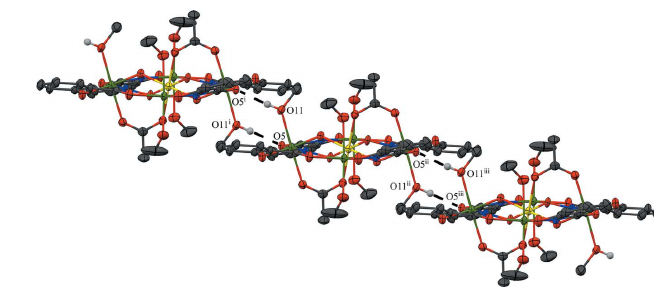
Figure 3 Intermolecular hydrogen bonding (dashed lines) between the carboxylate oxygen atom (O5) of a shi 3 (cid:3) ligand and a coordinated methanol molecule (O11) of a neighboring metallacrown that then generates a one- dimensional chain. For clarity only the hydrogen atoms involved in the interactions have been included. [Symmetry codes: (i) (cid:3) x + 1, (cid:3) y + 2, (cid:3) z + 1; (ii) (cid:3) x + 1, (cid:3) y + 1, (cid:3) z + 1; (iii) x , y (cid:3) 1, z .]